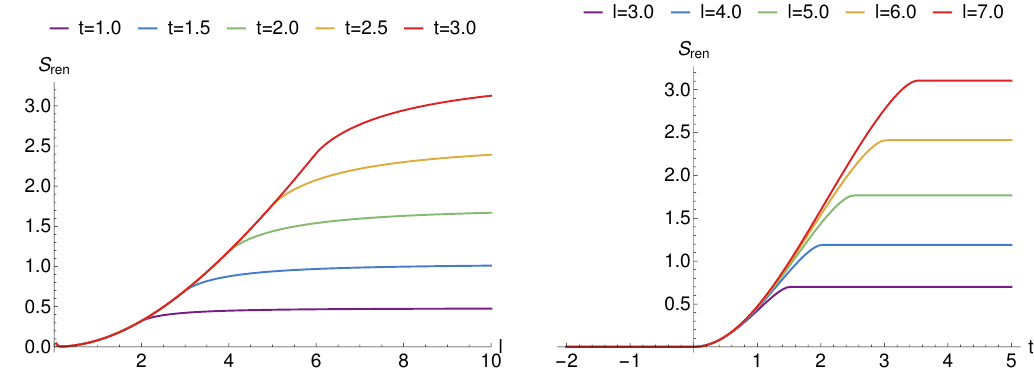
Figure 3: Left: vacuum subtracted HEE S of separation l . Right: S